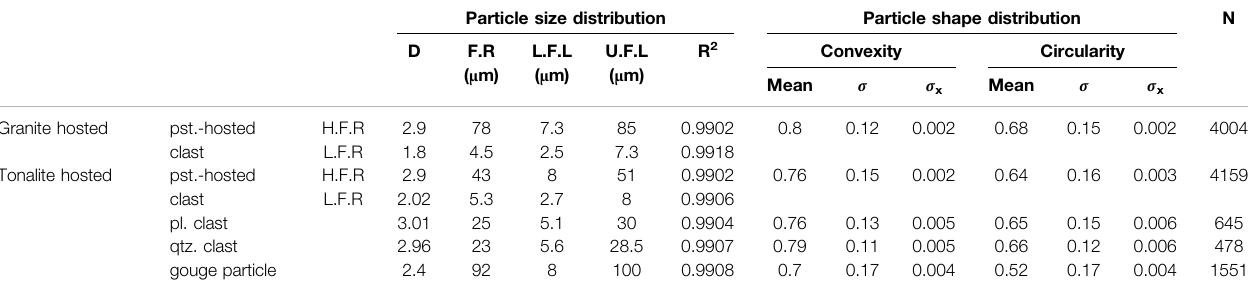
TABLE 3 | Values of the different parameters that characterize the particle size and shape distribution of tonalite and granite-hosted specimens.